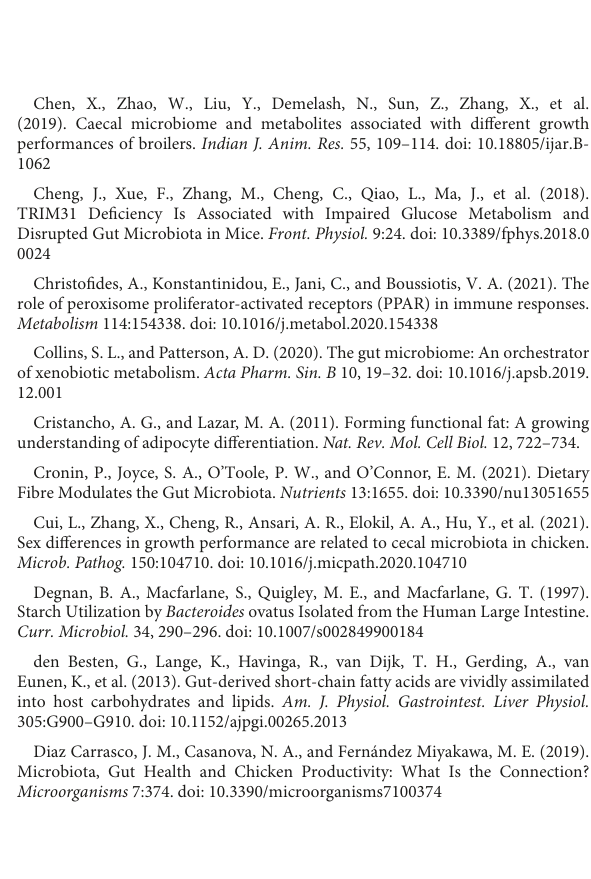
SUPPLEMENTARYFIGURE1 Response sequence test analysis and volcano plot of differential metabolite in positive ion and negative ion mode. SUPPLEMENTARYFIGURE2 Bar plot and Venn diagram of the number of metabolites in WL and SF separately in different categories. SUPPLEMENTARYFIGURE3 The metabolic pathways of bacterial metabolism and cometabolism pathways with the host. SUPPLEMENTARYFIGURE4 The Spearman correlation analysis between bacteria at genus level and metabolites. SUPPLEMENTARYFIGURE5 The BIO-Sankey network for several metabolic reactions in significantly different metabolism